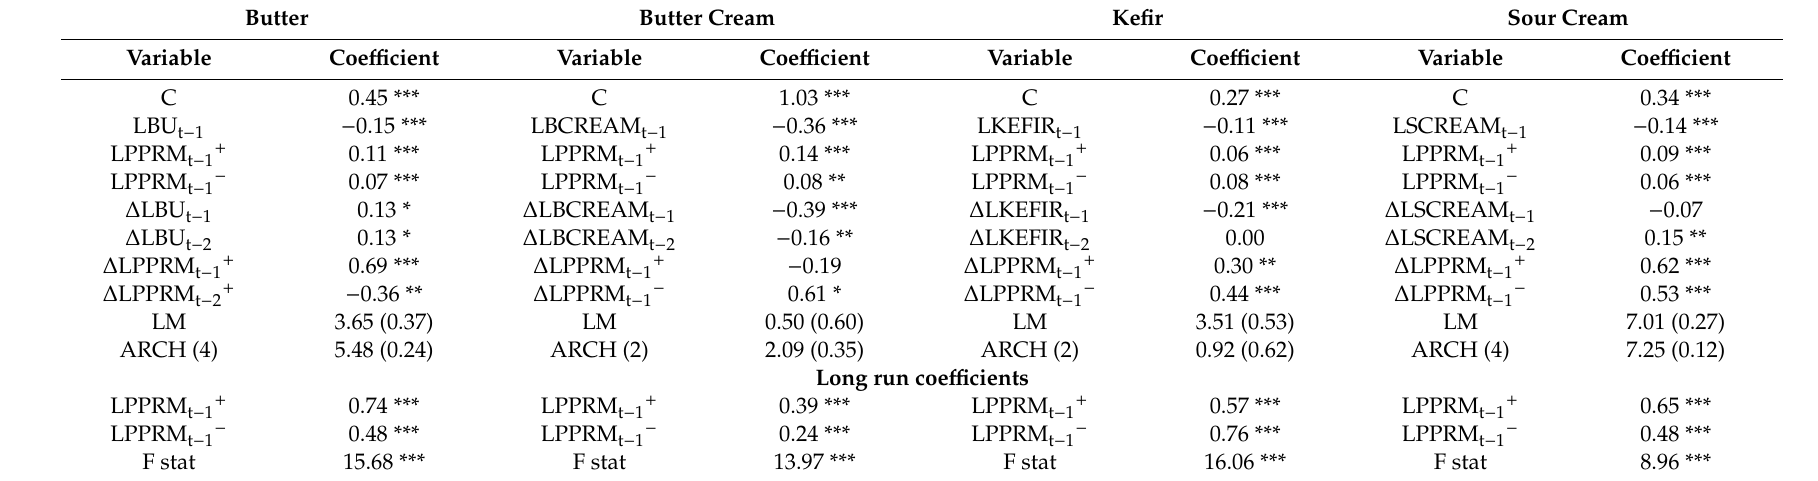
Table 4. Estimation results (dependent variable: